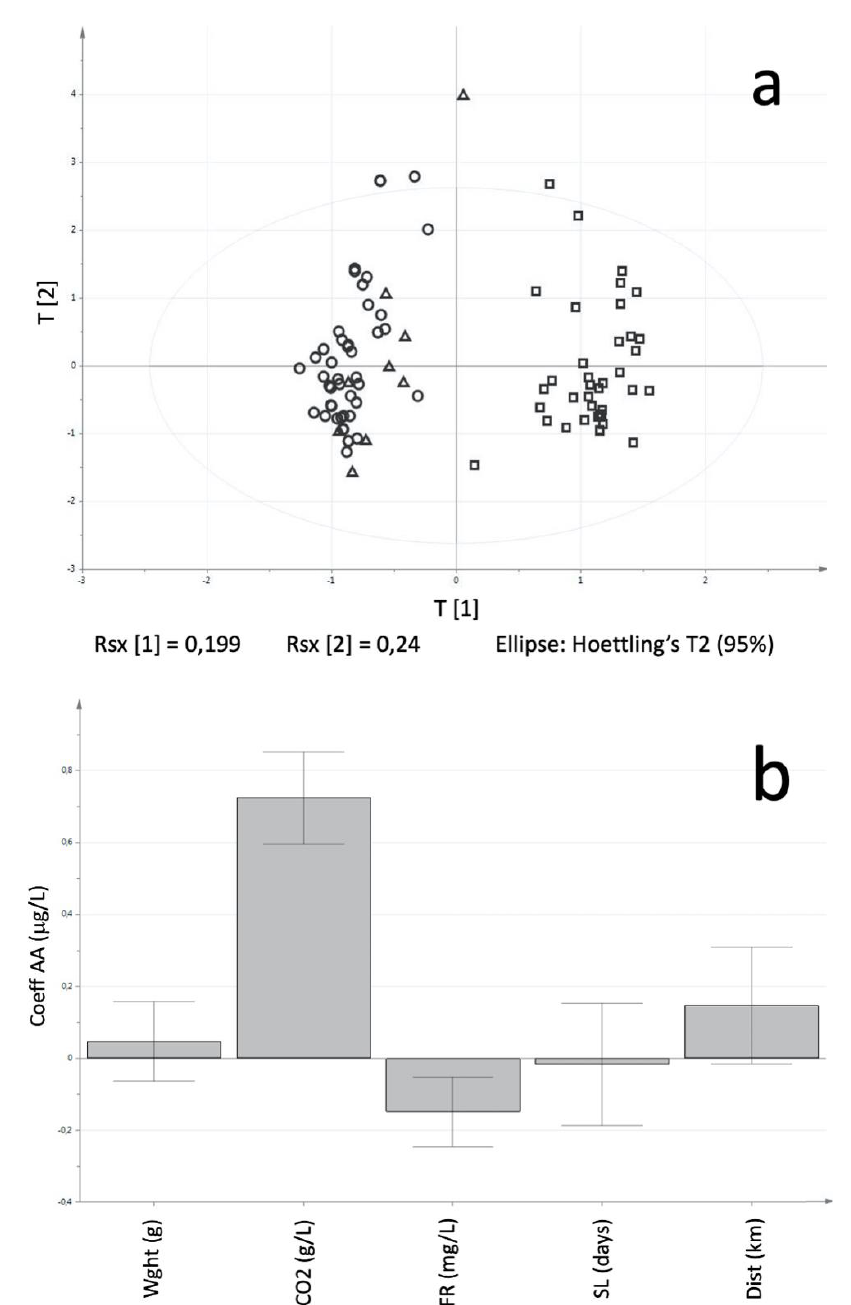
Figure 3. Results of projection to latent structures by means of partial least squares (PLS): ( a ) PLS score plot showing the samples in the space of the first (t[1]) and second (t[2]) principal component. Circles represent natural still waters, triangles the natural e ff ervescent waters and squares the carbonated sparkling waters; ( b ) PLS regression coe ffi cients, showing the influence of the di ff erent variables on the acetaldehyde concentration. (Legend: Wght = bottles weight, Dist = distance from production site, SL = shell life, FR = fixed